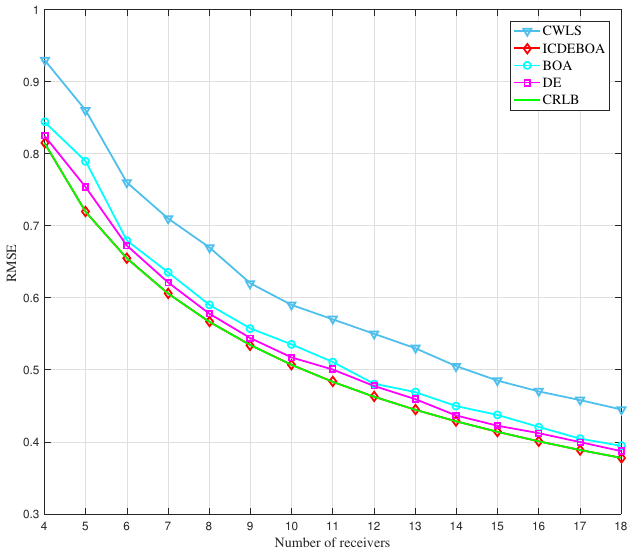
Figure 8. The change in RMSE performance of the considered algorithms with the increase in the participating transmitters for measurement noise variance σ 2 = 1 m 2